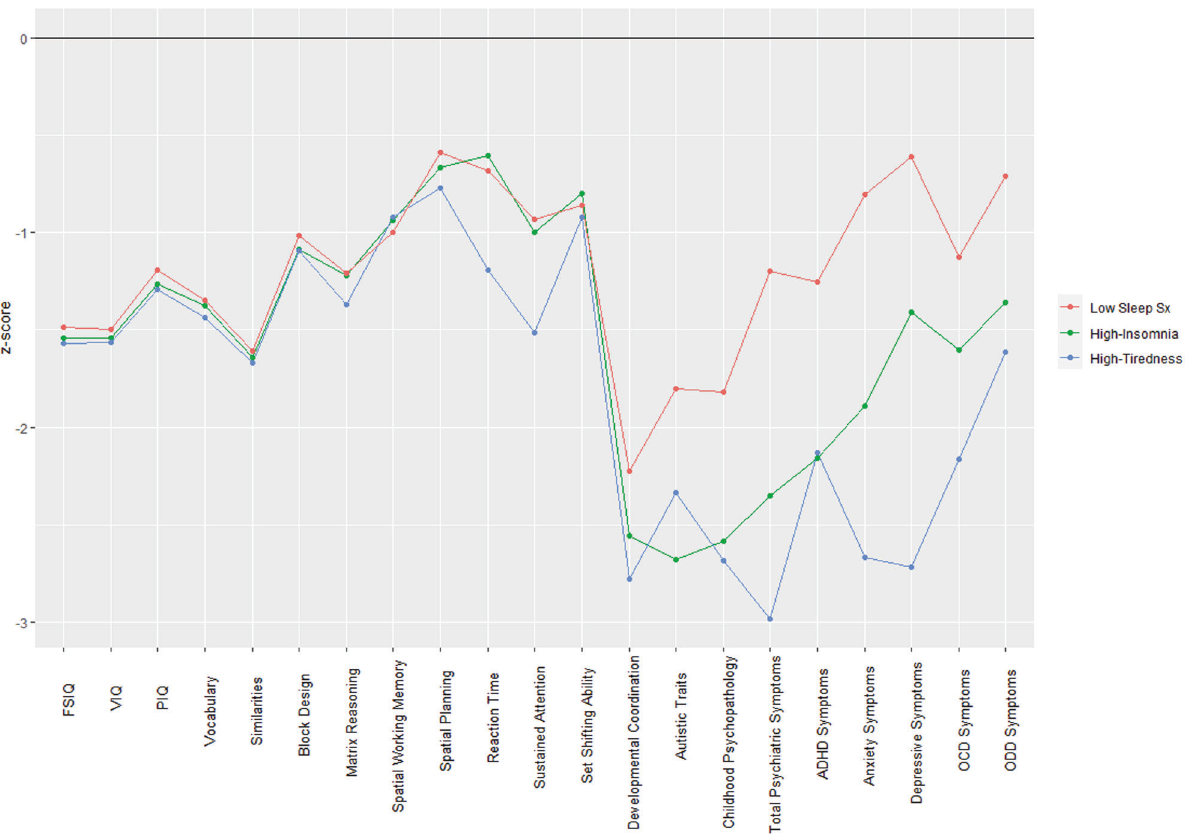
Fig. 2 Neuropsychiatric and cognitive pro fi les for children with a ND-GC presented by sleep class subgroup. For children with a ND-GC, the neuropsychiatric and cognitive pro fi les of each sleep class subgroup. z-scores were derived relative to the scores of the sibling controls, and were adjusted for age and